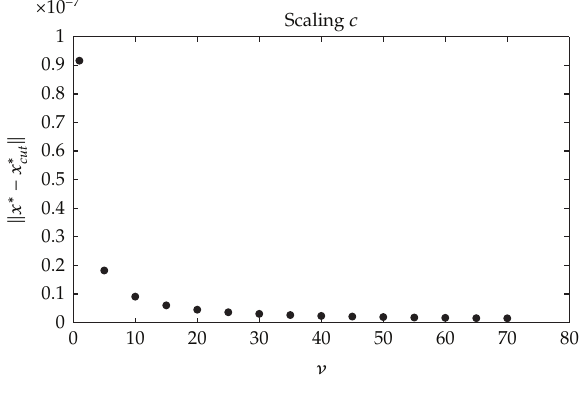
Figure 19: The e ff ect of scaling c